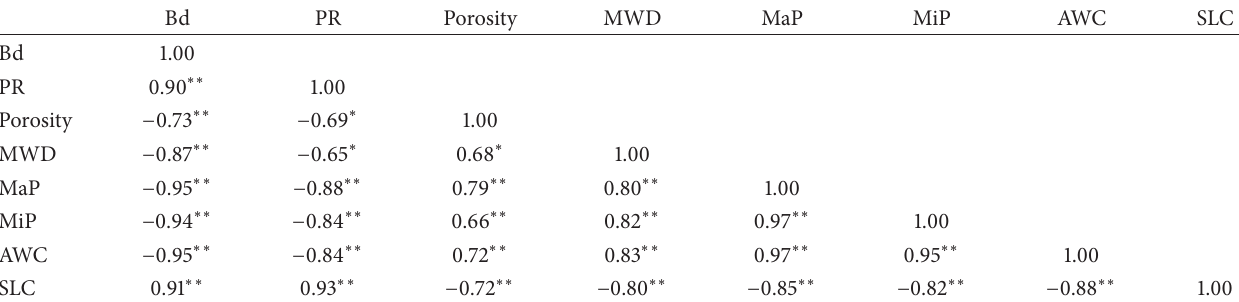
Table 5: Pearson’s correlation coefficients among soil properties at the end of incubation time (after 168d), 𝑛 =